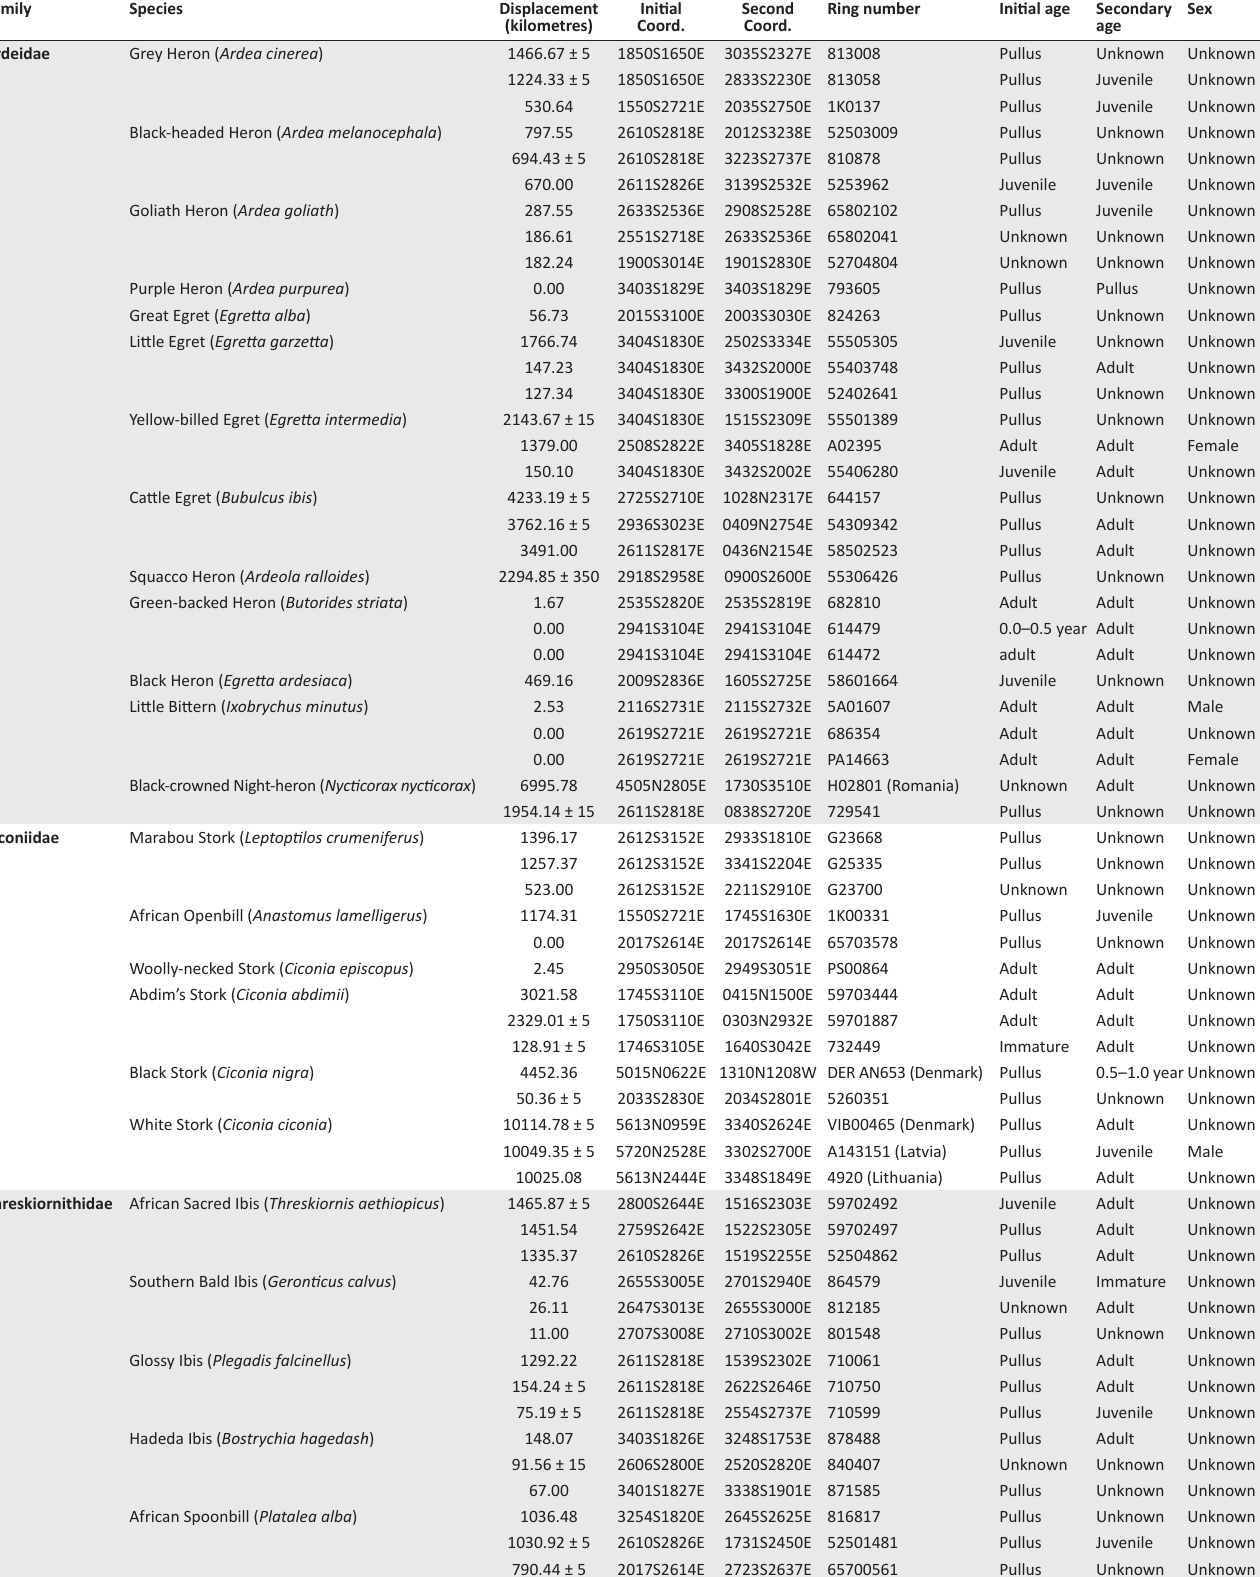
TABLE 1-A1: Top three displacement records of southern African Ardeidae, Threskiornithidae and Ciconiidae species from ringing records from the South African Ringing Scheme. Family